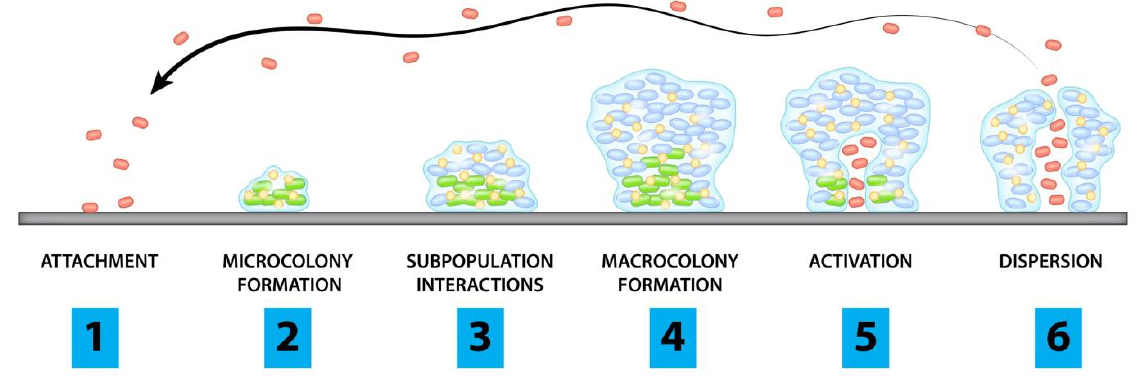
Figure 1. Stages of Biofilm Formation.